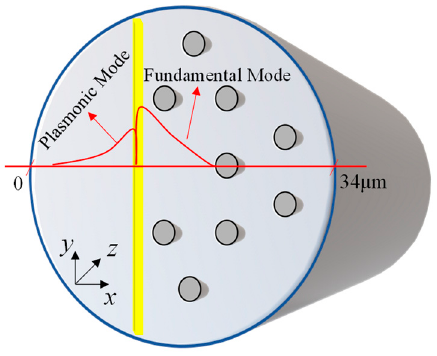
Figure 5. 1D analysis scheme of plasmonic and fundamental modes.